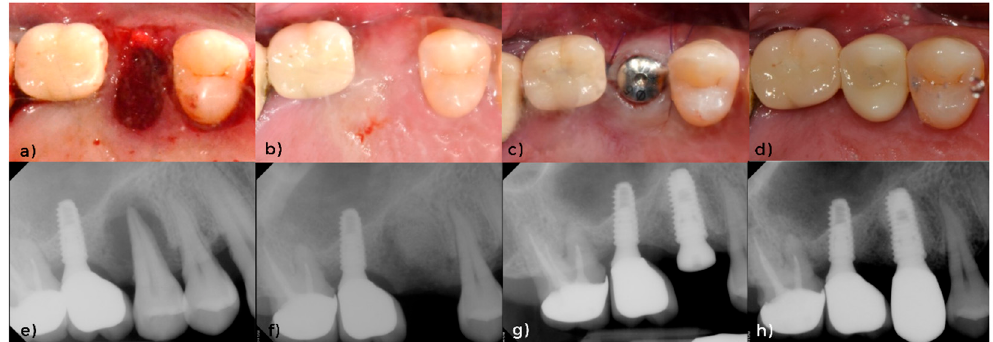
Figure 1. Clinical photos and peri-apical radiographs of Case I. Clinical photos of ( a ) after extraction, ( b ) one year after alveolar ridge preservation (ARP), ( c ) after implantation, ( d ) after prosthesis delivery. Peri-apical radiographs of ( e ) before extraction, ( f ) after ARP, ( g ) after implantation, ( h ) after prosthesis delivery.